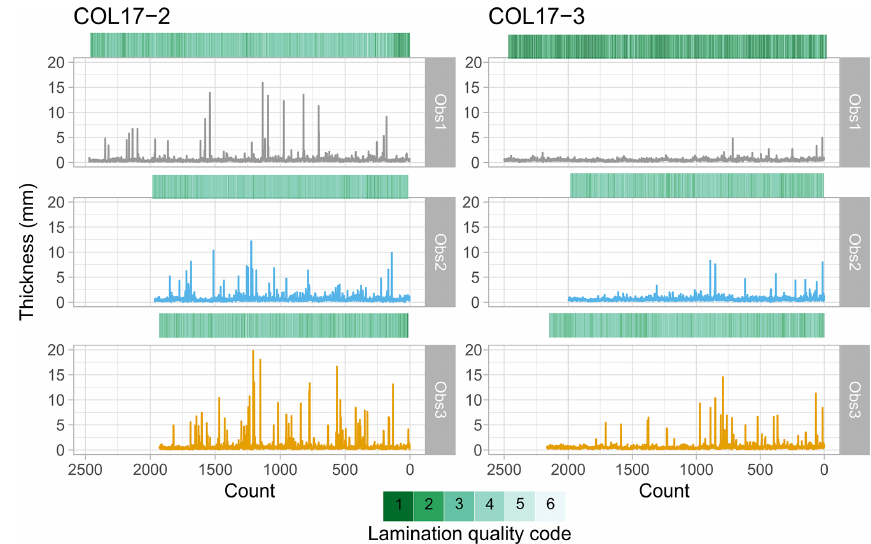
Figure 5. Observer measurements of lamination thicknesses (lines) and quality (heat maps) for cores COL17-2 and COL17-3.